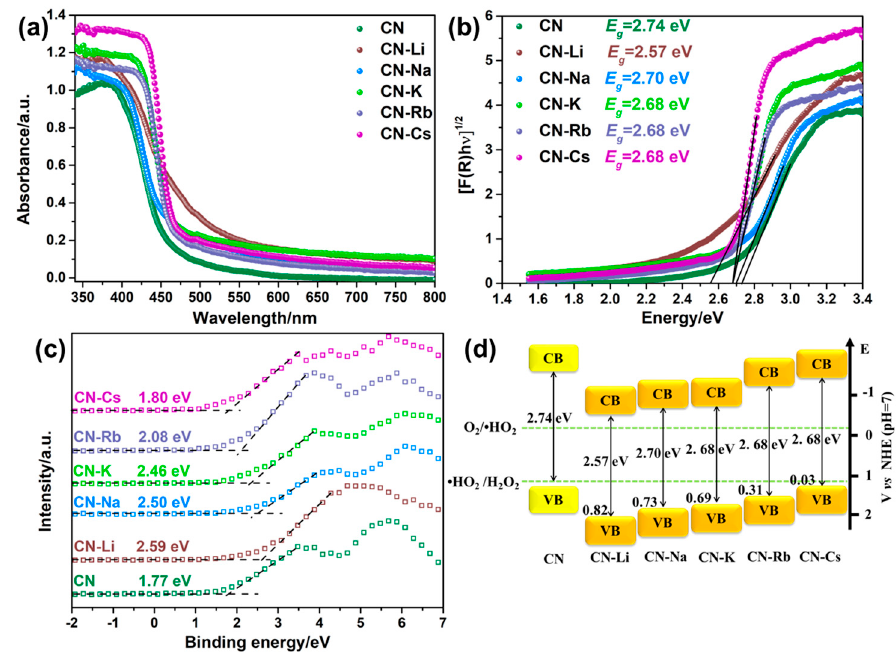
Figure 3. ( a ) DRS spectra of CN and CN-M. ( b ) The Kubelka–Munk plots of CN and CN-M. ( c ) XPS valence band spectra. ( d ) Electronic energy band positions of CN and CN-M.